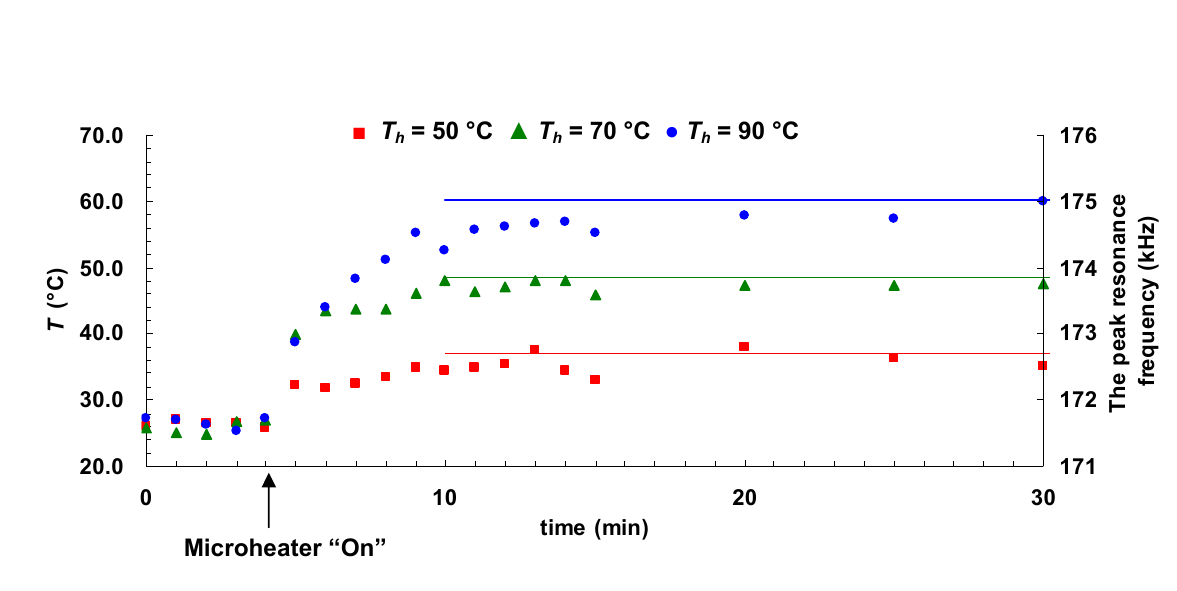
Figure 5. Transient temperature measurements at z = 40 µm while the microheater temperature T maintained at 50 ° C, 70 ° C, or 90 °